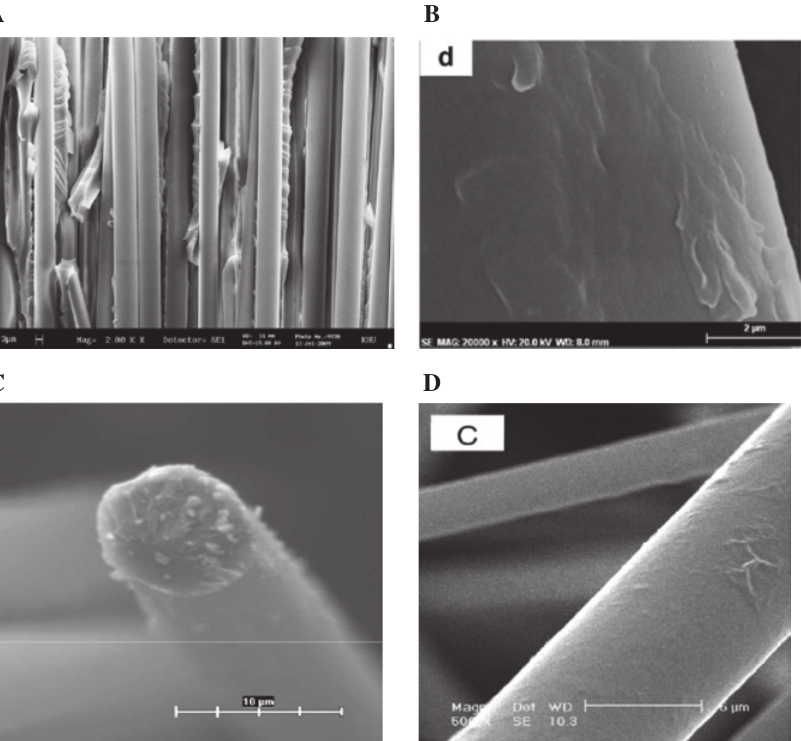
Figure 5: SEM image of basalt fiber and their composite after thermal treatment. (A) Fracture surface after oxygen plasma treatment [24], (B) BF after 4.5 min plasma polymerized [26], (C) BF failure surface treated with 250 ° C for 60 min [22], (D) BF surface after 10 min plasma treatment